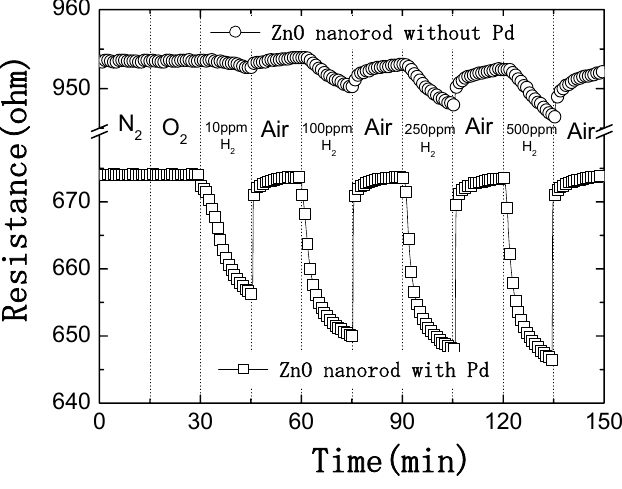
Figure 3. Time dependence of resistance of either Pd-coated or uncoated multiple ZnO nanorods as the gas ambient is switched from N (10-500